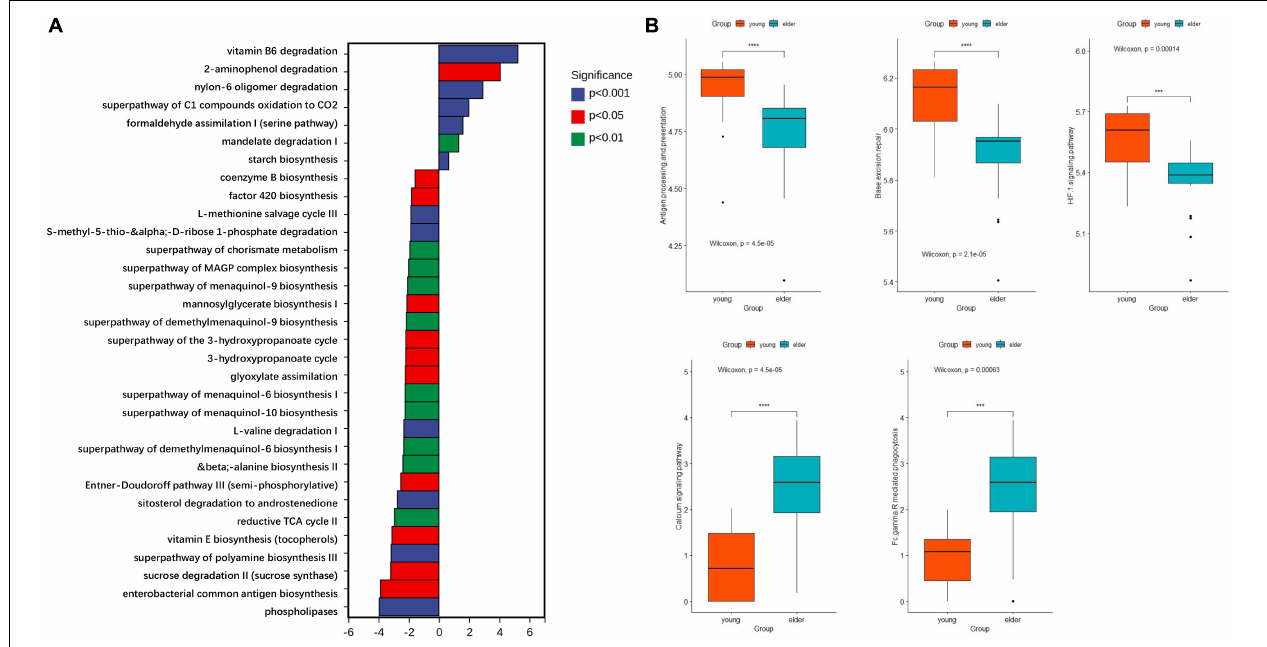
FIGURE 6 | Functional prediction of microbiota by metabolic (A) and cancer related signaling pathways (B) . The top enriched metabolic pathways in the young OSCC microbiota were vitamin B6 degradation, 2-aminophenol degradation, super pathway of oxidation of C 1 compounds to CO 2 and formaldehyde assimilation I. *** p < 0.001 and **** p <